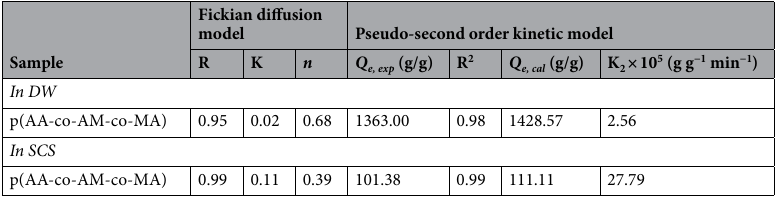
Table 1. Swelling kinetic parameters of p(AA-co-AM-co-MA) superabsorbent.